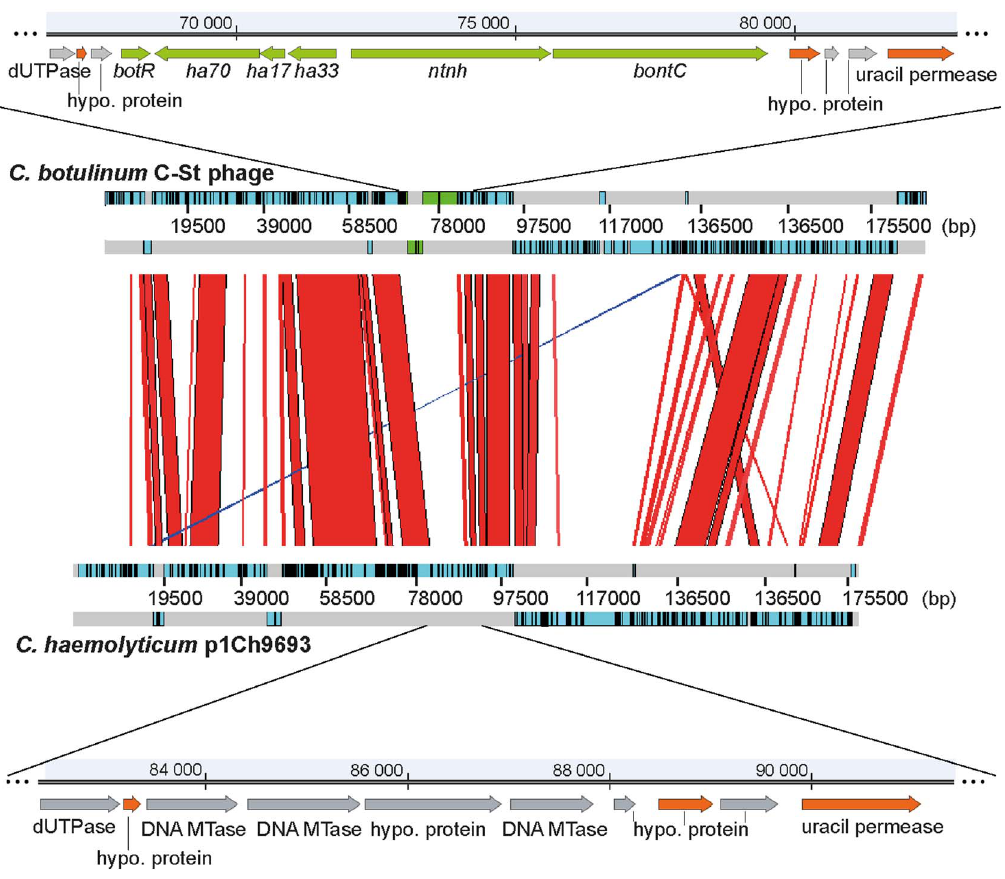
Figure 3. Sequence comparison between the C-St BoNT-encoding phage and the p1Ch9693 phage from a C.haemolyticum strain. Artemis Comparison Tool (ACT) plot of an alignment between the C-St BoNT-encoding phage from C. botulinum strain C-Stockholm and p1Ch9693 from C. haemolyticum strain NCTC 9693. Regions of similarity are indicated in red (same direction) or blue (opposite direction). Genes in the bont cluster are green, genes homologous between the two replicons are orange, and remaining genes are gray.